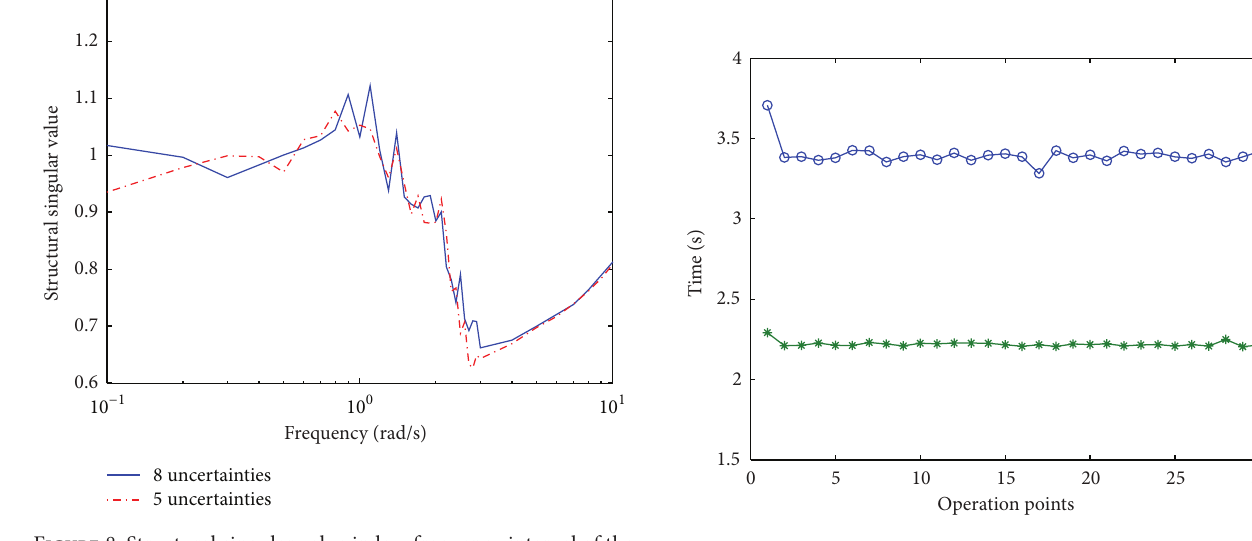
Figure 8: Structural singular value in low frequency interval of the uncertain systems.